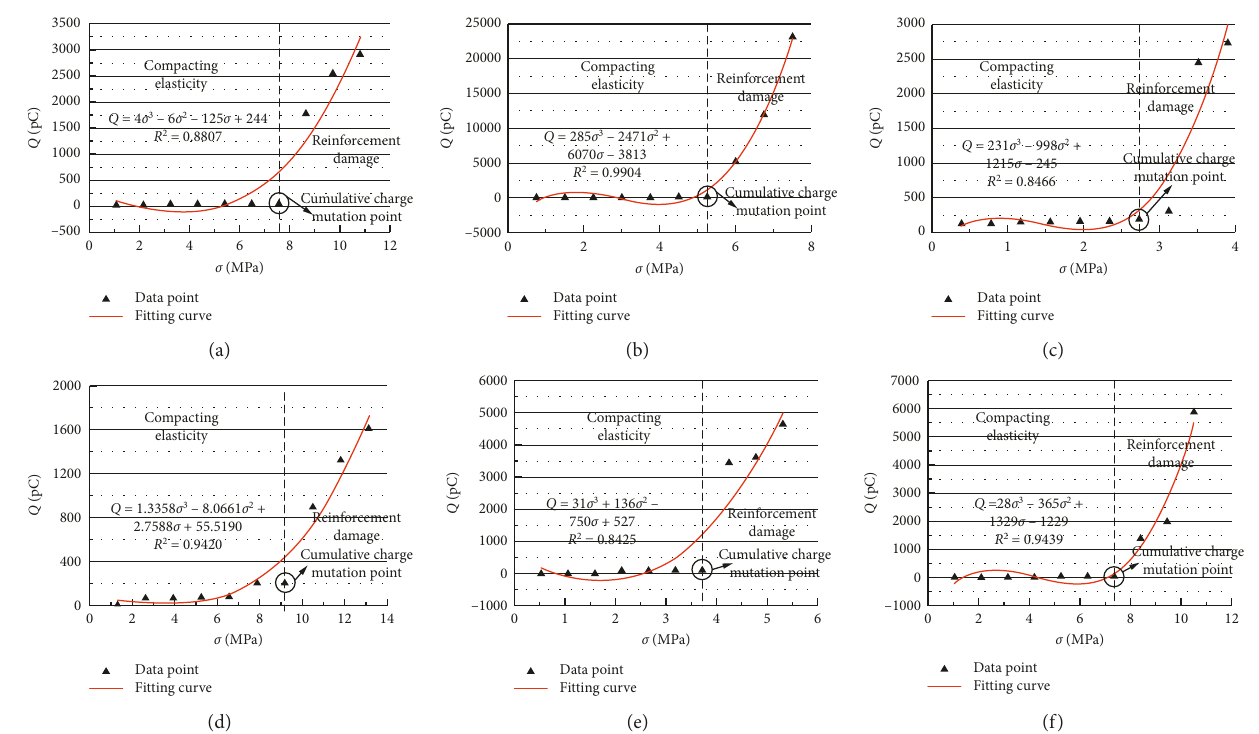
Figure 7: Fitting relationship between stress and cumulative charge of coal samples under uniaxial compressive. (a) Sample 1. (b) Sample 2. (c) Sample 3. (d) Sample 4. (e) Sample 5. (f) Sample 6.